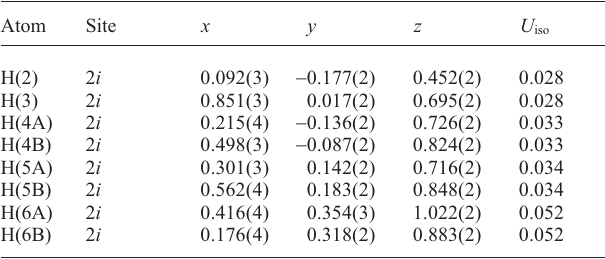
Table 2. Atomic coordinates and displacement parameters (in Å 2 )